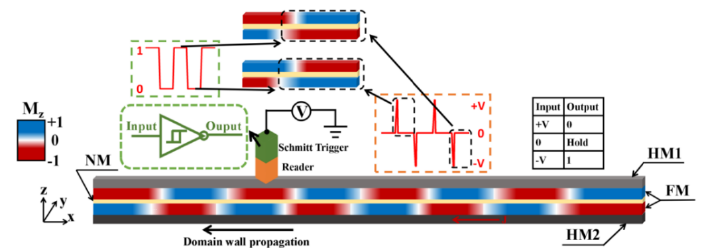
Figure 1. The schematic of the model and principle for the readable SAF racetrack